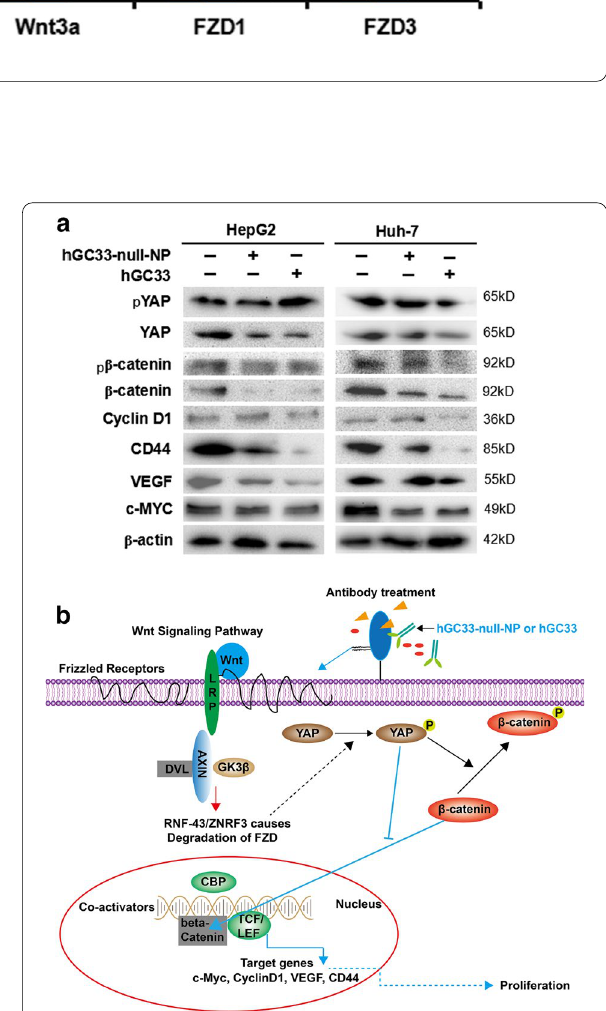
Fig. 7 Inhibition of Wnt3a-induced β-catenin signaling by hGC33-null-NP or hGC33. a Compared with the control group, Wnt/ β-catenin signaling pathway in HepG2 and Huh-7 cells treated with hGC33-null-NP or hGC33 was inhibited, and the levels of β-catenin and YAP were decreased, while the increased phosphorylated β-catenin and phosphorylated YAP molecules were unstable, and degraded in cytoplasm. The decreased β-catenin was difficult to maintain in the nucleus and drive the expression of CyclinD1, CD44, VEGF, and c-MYC, which resulted in the decrease of cyclinD1, CD44, VEGF, and c-myc protein levels. b The mechanism pattern of Wnt/ β-catenin signaling pathway inhibited by hGC33-null-NP or